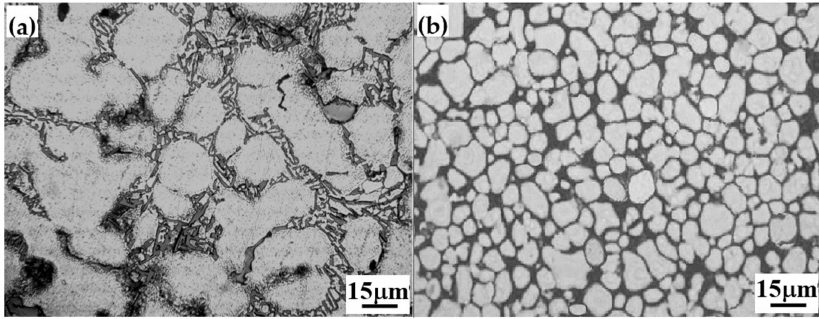
Figure 1. Microstructure of metal-mold cast and die-cast Al-9Si-4Cu-0.4Mg-0.3Sc alloys. ( a ) Microstructure of a metal-mold cast alloy; and ( b ) microstructure of a die-cast alloy.